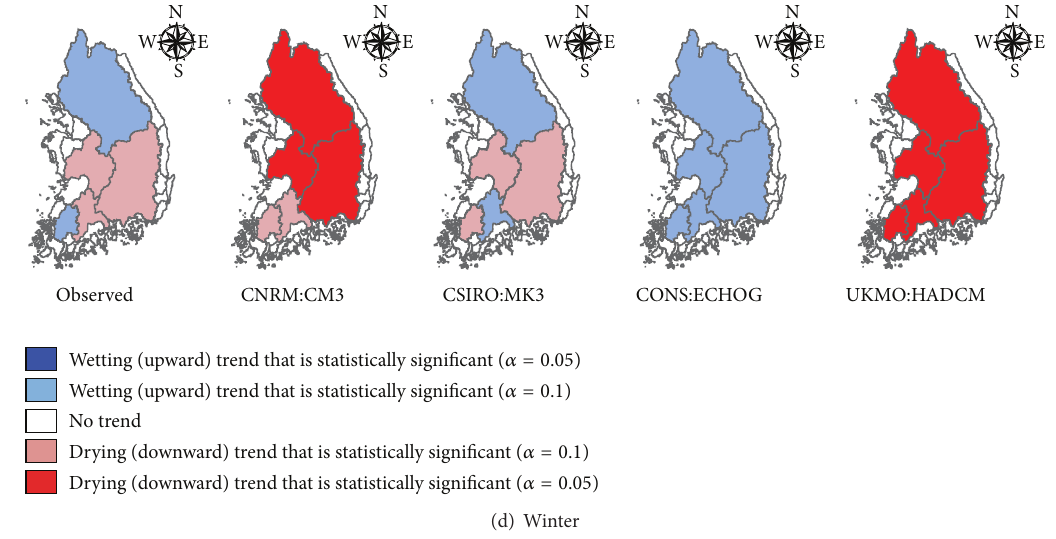
Figure 4: Results of drought trend analysis for each season using the Mann-Kendall test (confidence level ≥